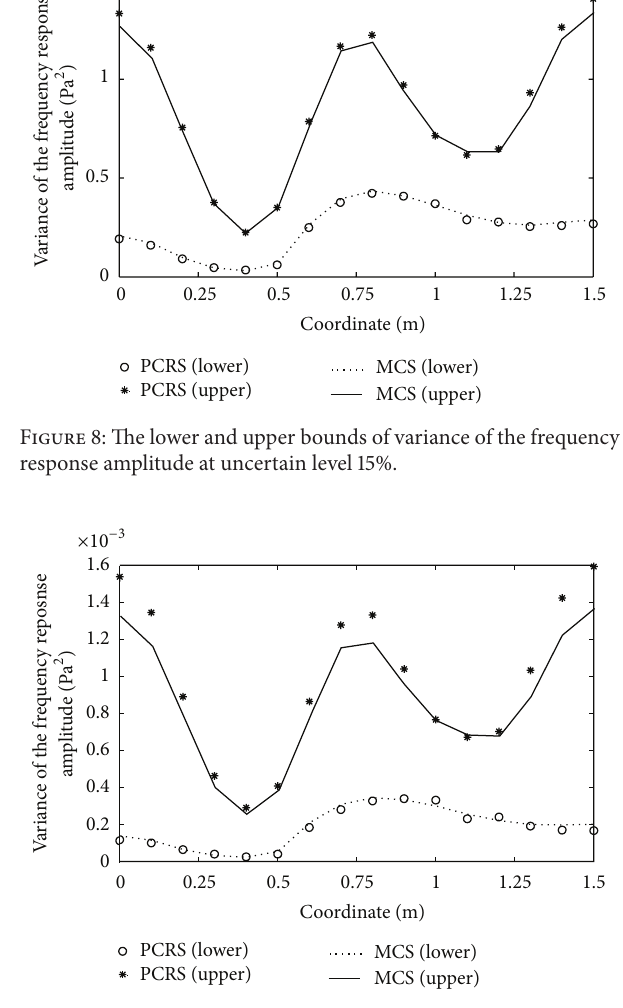
Figure 7: The lower and upper bounds of variance of the frequency response amplitude at uncertain level 10%.